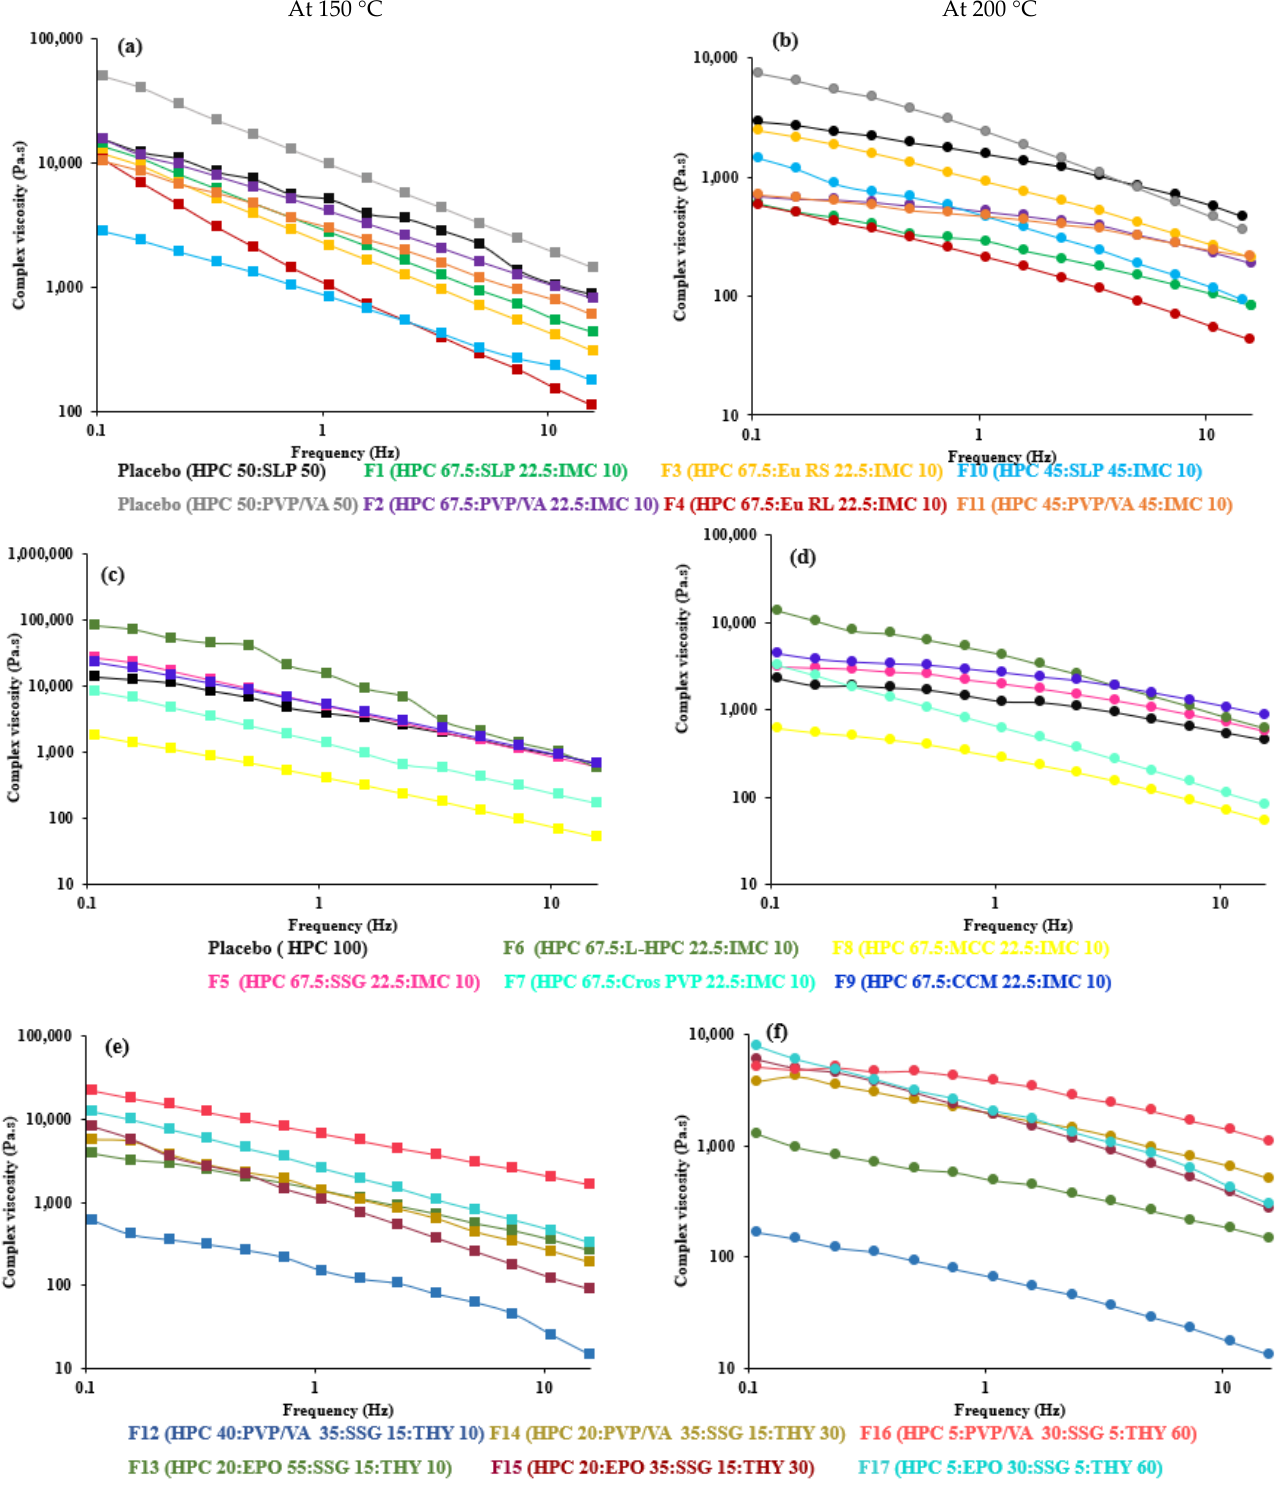
Figure 2. Effect of angular frequency (0.1 to 15 Hz) on complex viscosity of 67.5–45% HPC:polymer mixtures ( a , b ), 67.5% HPC:disintegrant mixtures ( c , d ) and 40–5% HPC:polymer mixtures ( e , f ) at 150 °C ( left ) and 200 °C ( right ) .